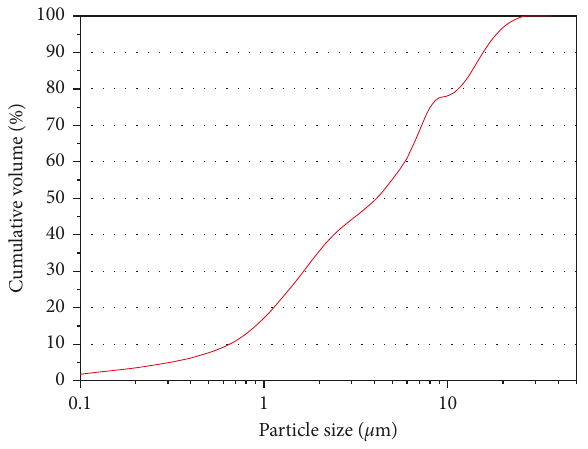
Figure 3: PSD of limestone powder. Table 1: Chemical composition of cement and limestone (%). Portland cement